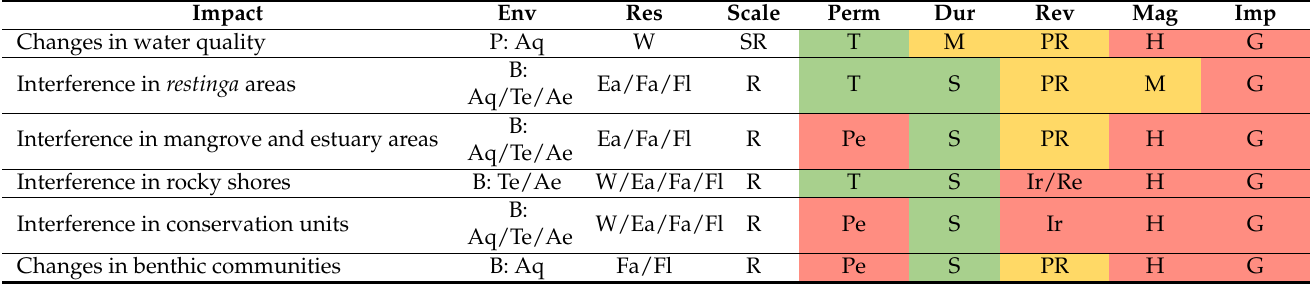
Table 8. Potential impacts during the drilling